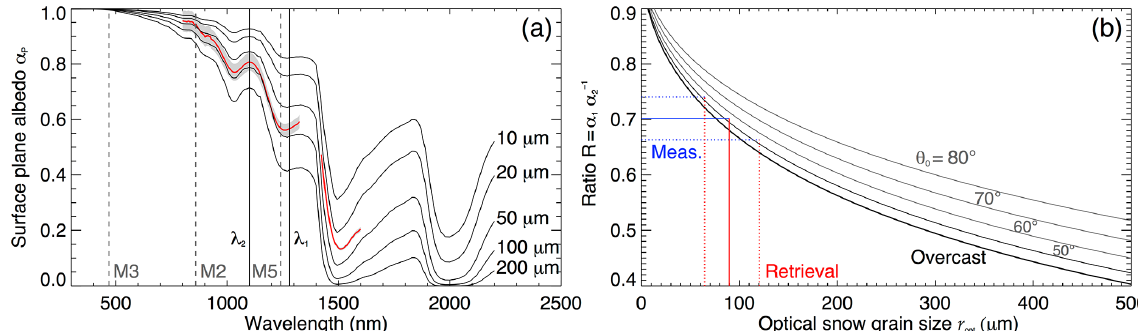
Figure 4. (a) Surface plane albedo for optical snow grain sizes between 10 and 200µm; θ 0 = 54 ◦ and A = 5 . 8 ( χ data from Warren and Brandt, 2008). M3, M2, and M5 mark MODIS spectral bands used within the SGSP algorithm. λ 1 and λ 2 denote wavelengths used within the CORAS and SMART grain size retrieval. The red solid line and shaded gray show a spectral albedo measured by CORAS on 24 De- cember 2013 (14:00UTC). (b) Illustration of retrieval principle. Dependence of ratio R with respect to optical snow grain size for different solar zenith angles (50 to 80 ◦ ) and for overcast conditions; A = 5 . 8 ( χ data from Warren and Brandt, 2008). Blue and red lines illustrate the retrieval of optical snow grain size from a measured albedo ratio R = 0 . 7 with a relative uncertainty of